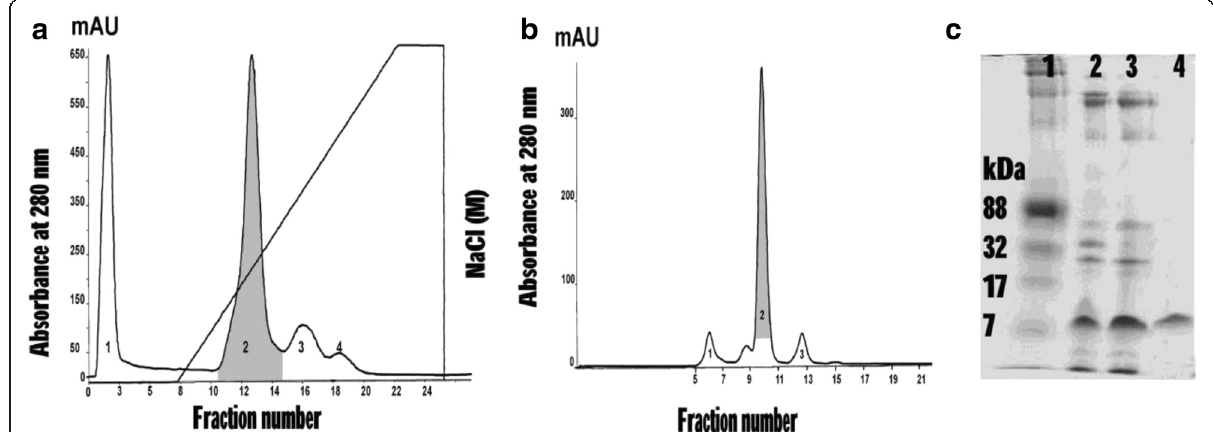
Fig. 1 A dssPLA 2 was isolated from Daboia siamensis venom. ( a ) Ion exchange chromatography of Daboia siamensis venom on HiTrap ™ CM FF column. Protein was eluted with linear gradient 0 – 1 M NaCl. The peak with gray-shaded area was PLA 2 activity. ( b ) Peak 2 from the first step was applied on Superdex ™ 75 10/300 GL column. Elution was carried out with 10 mM PBS, pH 7.3. ( c ) SDS-PAGE analysis of venom and theirs fractions. Lane 1: protein markers, lane 2: crude venom, lane 3: fraction no.2 from ion exchange chromatography, and lane 4: fraction no. 2 from gel filtration